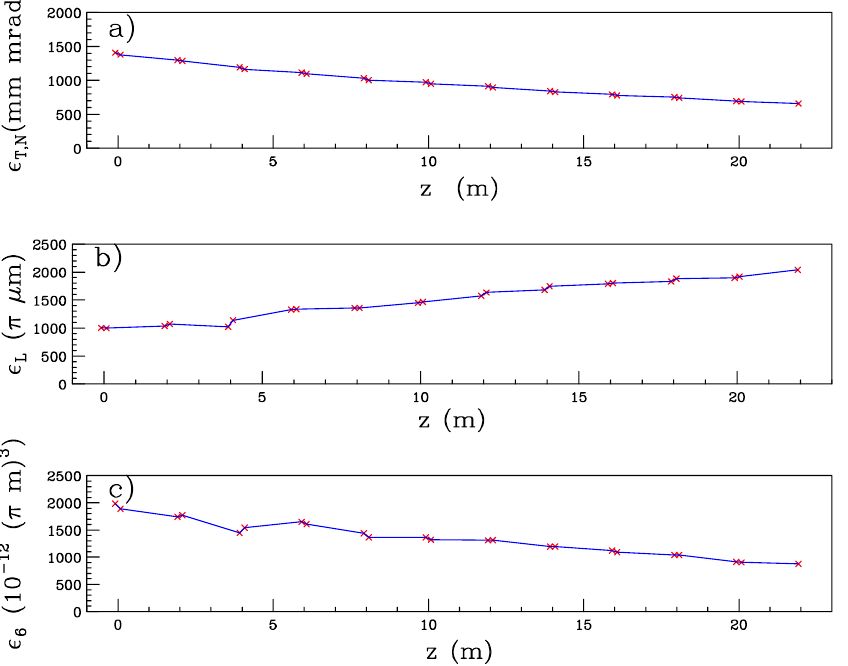
FIG. 28. (Color) Emittance vs z : (a) transverse emittance e T , N (cid:3) p mm mrad (cid:4) , (b) longitudinal emittance e L (cid:3) 10 2 3 p mm (cid:4) , and (c) 6D emittance e 6 (cid:3) 10 2 12 p m 3 (cid:4) .